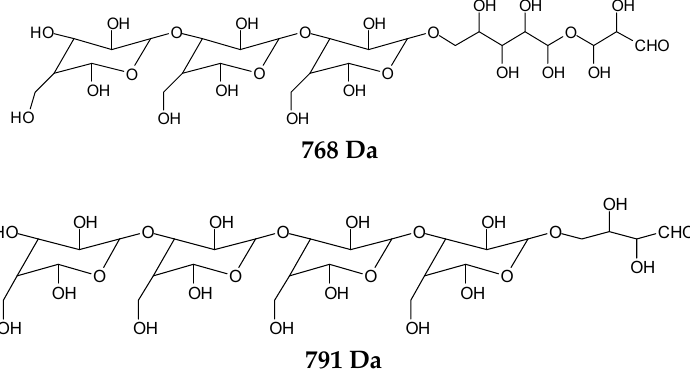
Figure 1. MALDI ToF spectra of insoluble soy flour carbohydrates after a treatment with sodium periodate at 120 °C for 1 hour. ( a ) 100 Da to 500 Da range. ( b ) 500 Da to 1000 Da range. ( c ) 1000 Da to 1500 Da range.